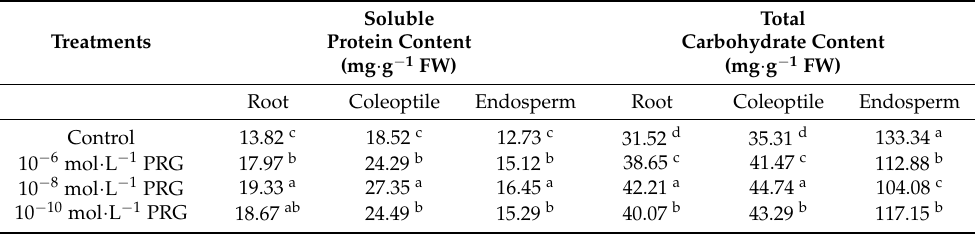
Table 1. Effects of progesterone applications on soluble total protein content and total carbohydrate content in root, coleoptile, and endosperm tissues in 4-day-old maize seeds.